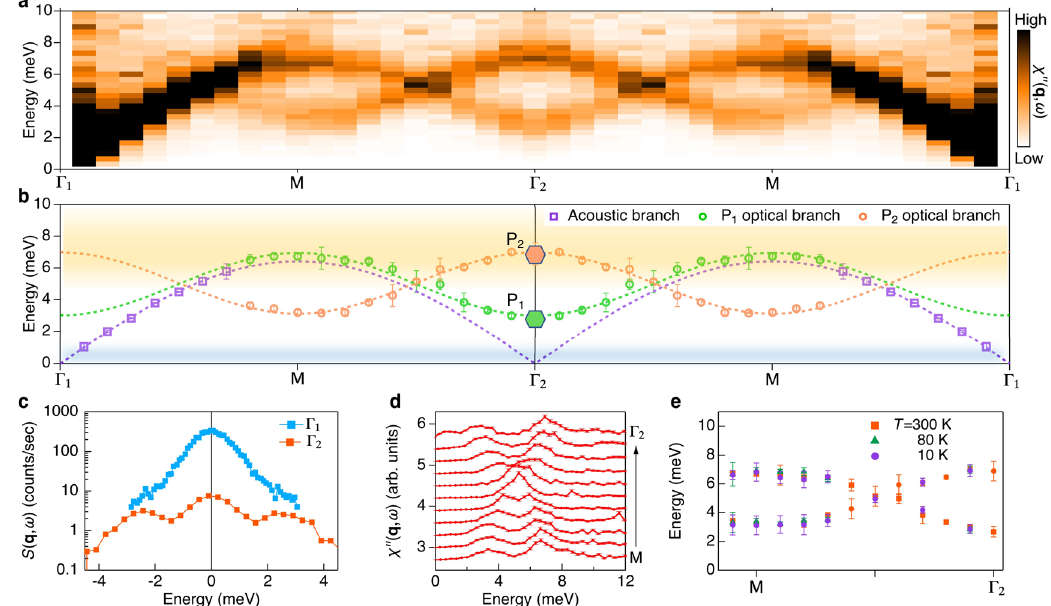
Fig. 2 Room temperature phonon excitations in α -RuCl 3 . a Low-energy phonon excitations determined by IXS along the Γ 1 (6, − 3, 0) – M (6, − 2.5, 0) – Γ 2 (6, − 2, 0) direction. The plot shows the Bose-factor corrected IXS intensity. The extracted peak positions are presented in ( b ) revealing interlaced optical phonons intercepting with the transverse acoustic phonon branch. The optical phonon energies at Γ 2 are denoted by the green (P 1 ) and orange (P 2 ) hexagons, which are consistent with the phonon modes previously found by THz-spectroscopy 38 . The yellow and blue shaded areas correspond to the two characteristic Kitaev energy scales displayed in Fig. 1d. c IXS spectra at Γ 1 and Γ 2 . The intensity is shown on a logarithmic scale. Note that due to the large intensity difference at Γ 1 and Γ 2 , the acoustic phonon intensity is expected to be extremely weak near Γ 2 . d Constant momentum transfer cuts around the phonon-crossing. The two optical branches cross each other without imposing a hybridization gap. e The extracted phonon peak positions from M to Γ 2 at different temperatures reveal a temperature-independent massless Dirac-cone. The error bars in b , e denote the 2 σ returned from the fi ttings (see Supplementary Note 2). The error bars in d represent one standard deviation assuming Poisson counting